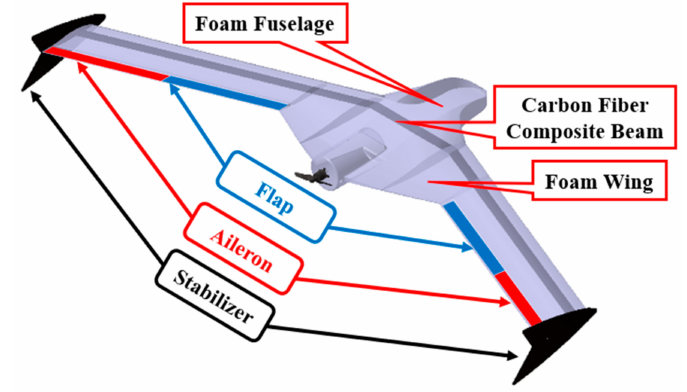
Figure 8. CAD model of the BFF wind tunnel test on the